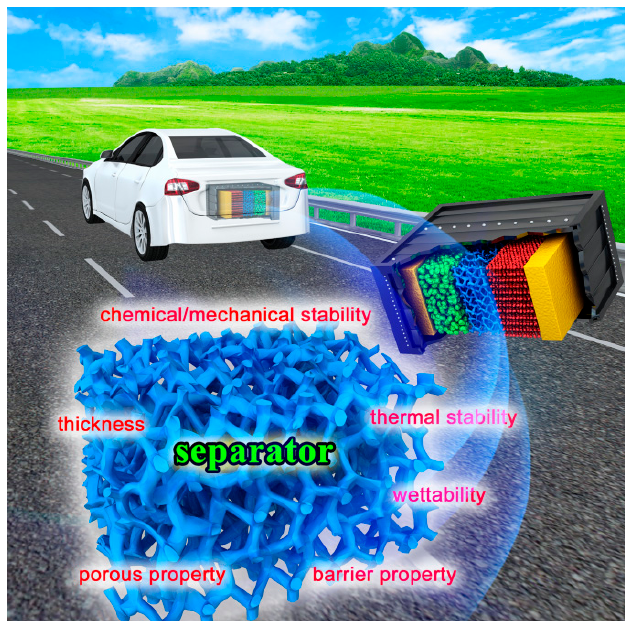
Figure 16. The schematic diagram of separator and the requirement for safety.